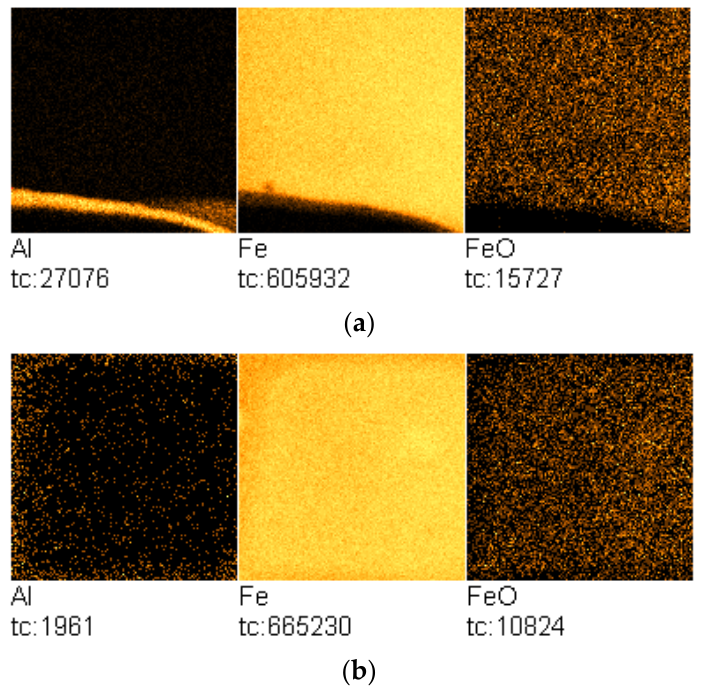
Figure 8. ( a ) TOF-SIMS image of the iron-sample surface with the visible region containing aluminum oxide (field of view: 500 × 500 μ m 2 ; sample Fe/Al(OH) 3 ); ( b ) TOF-SIMS image of the sample surface area on which TOF-SIMS temperature-programmed analysis was performed (field of view: 500 × 500 μ m 2 ; sample Fe/Al-T). Total counts (tc) for particular ions are presented below each image.